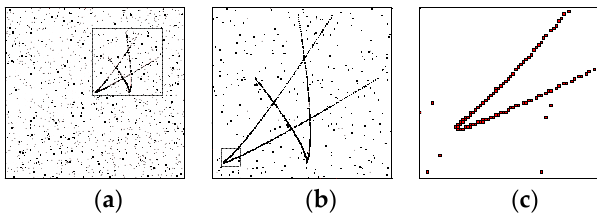
Figure 10. Measurements. ( a ) is all the measurements in the whole field of view, ( b ) is an enlargement